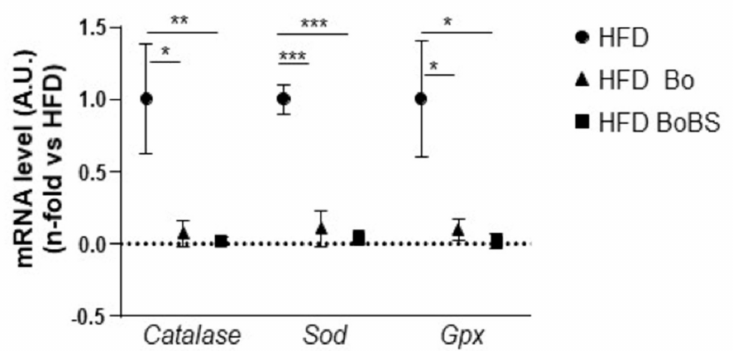
Figure 2. Effect of HFD (black circle, n = 5, samples from 5 males) or HFD containing Bolero under standard condition (Bo, black triangle, n = 6, samples from 6 males) or Bolero under biotic stress condition (BoBS, black square; n = 6, samples from 6 males) for 14 weeks on liver oxidative stress in ApoE − / − mice. Hepatic relative mRNA levels of three antioxidant enzymes: catalase, superoxide dismutase ( Sod ), and glutathione peroxidase ( Gpx ). Data were given as mean ± SEM. * p < 0.05, ** p < 0.01, *** p < 0.001 vs., HFD